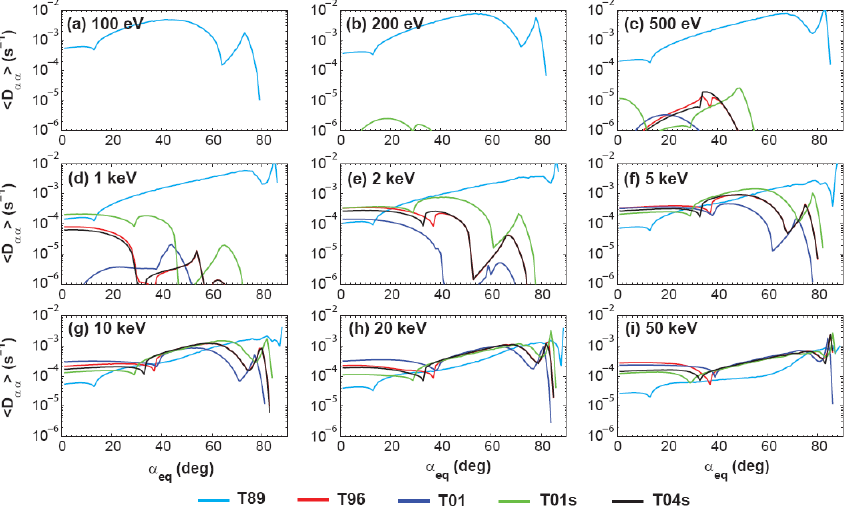
Fig. 5. Bounce-averaged pitch angle scattering coefficients h D αα i as a function of equatorial pitch angle α eq for plasma sheet electrons at Figure 5 . Bounce-averaged pitch angle scattering coefficients the nine specified energies from 100eV to 50keV due to dayside chorus waves corresponding to the YRS equatorial pitch angle  for plasma sheet electrons at the nine specified energies from 630 eq 100 eV to 50 keV due to dayside chorus waves corresponding to the YRS location. 631